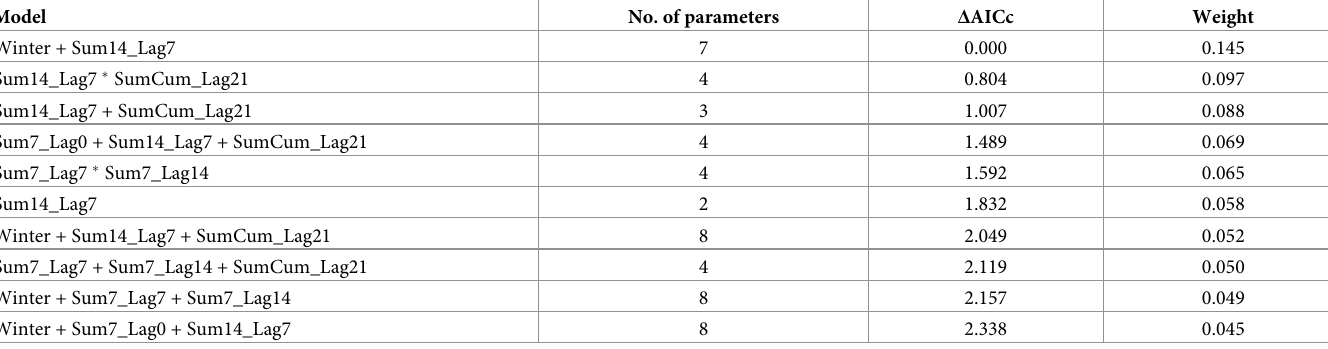
Table 3. Top 10 models for 7-day counts of cold-related manatee carcasses reported in the central-west region based on water temperature. Model